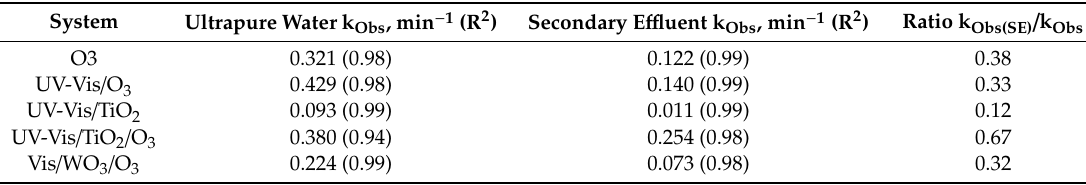
Table 2. Apparent pseudo-fist order rate constants of PRM degradation by di ff erent AOPs. Influence of the water